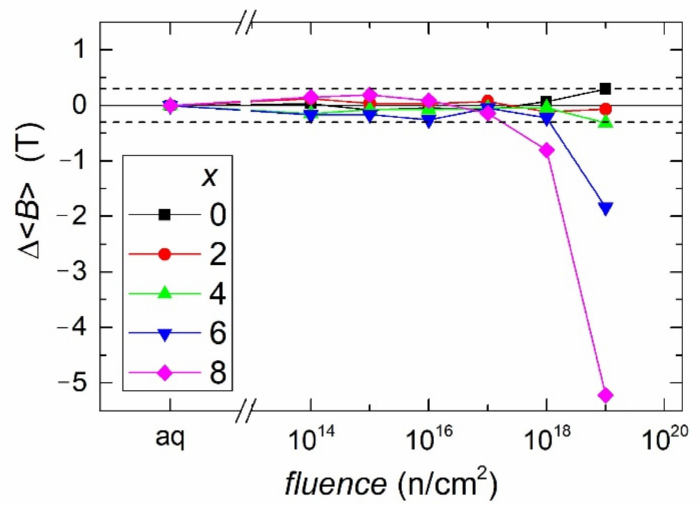
Figure 8. Differences of average hyperfine magnetic fields, ∆ (cid:104) B (cid:105) , between non-irradiated and irradiate Fe 30 Ni 48- x Cr x Mo 2 Si 5 B 15 plotted against the neutron fluence for the indicated Cr contents. Solid lines are only guides to an eye, dashed lines represent the error